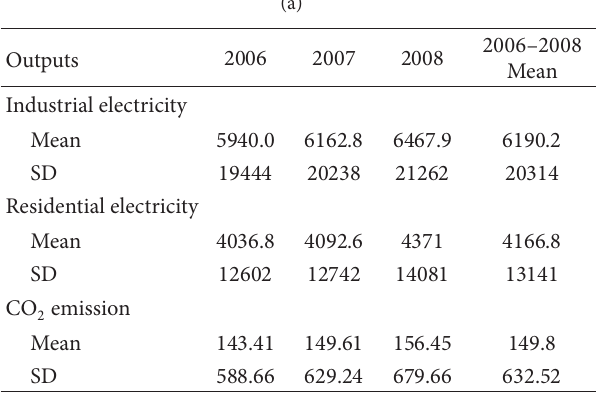
Table 1: Basic statistics analysis of output and inputs (DMUS = 73